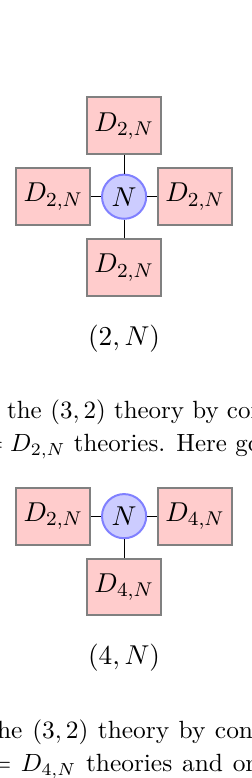
Figure 4 . We may also generalize the (3 , 2) theory by considering a diagonal exactly marginal SU( N ) gauging of two D 4 (SU( N )) := D 4 ,N theories and one D 2 (SU( N )) := D 2 ,N SCFT. Here gcd(4 , N ) = 1